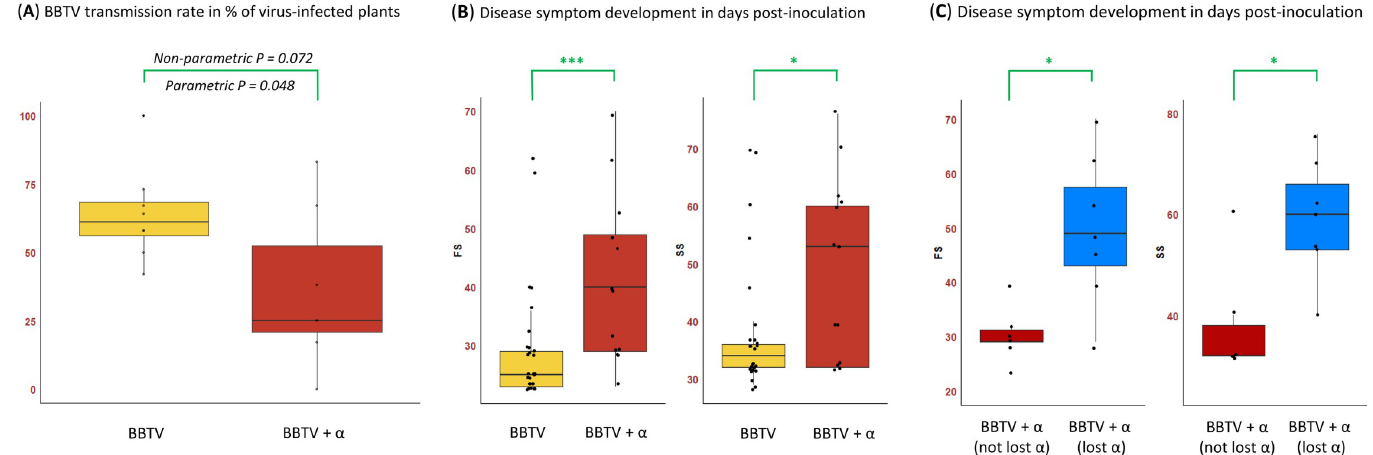
Fig 3. Impact of DRC alphasatellite on BBTV transmission by banana aphids and disease symptom development in recipient plants. ( A ) Transmission rates in percentage of virus-infected recipient plants per source plant infected with BBTV alone (n = 8) and co-infected with BBTV and alphasatellite (n = 7) are shown for two transmission experiments (C and D). Statistical significance of differences in the transmission rates with and without alphasatellite was calculated using in a parametric linear model test and a non-parametric Kruskal-Wallis and the resulting P-values are indicated. ( B ) Delay in development of first (FS) and systemic (SS) symptoms in recipient plants in days post-inoculation with BBTV alone (n = 26) and BBTV+alphasatellite (n = 13) in the transmission experiment D. ( C ) Delay in development of first (FS) and systemic (SS) symptoms in the recipient plants of experiment D in days post-inoculation with BBTV+alphasatellite plotted separately for the plants that contained alphasatellite (n = 6) and those that lost alphasatellite (n = 7). � Kruskal-Wallis P < 0.05. ��� Kruskal-Wallis P < 0.005.